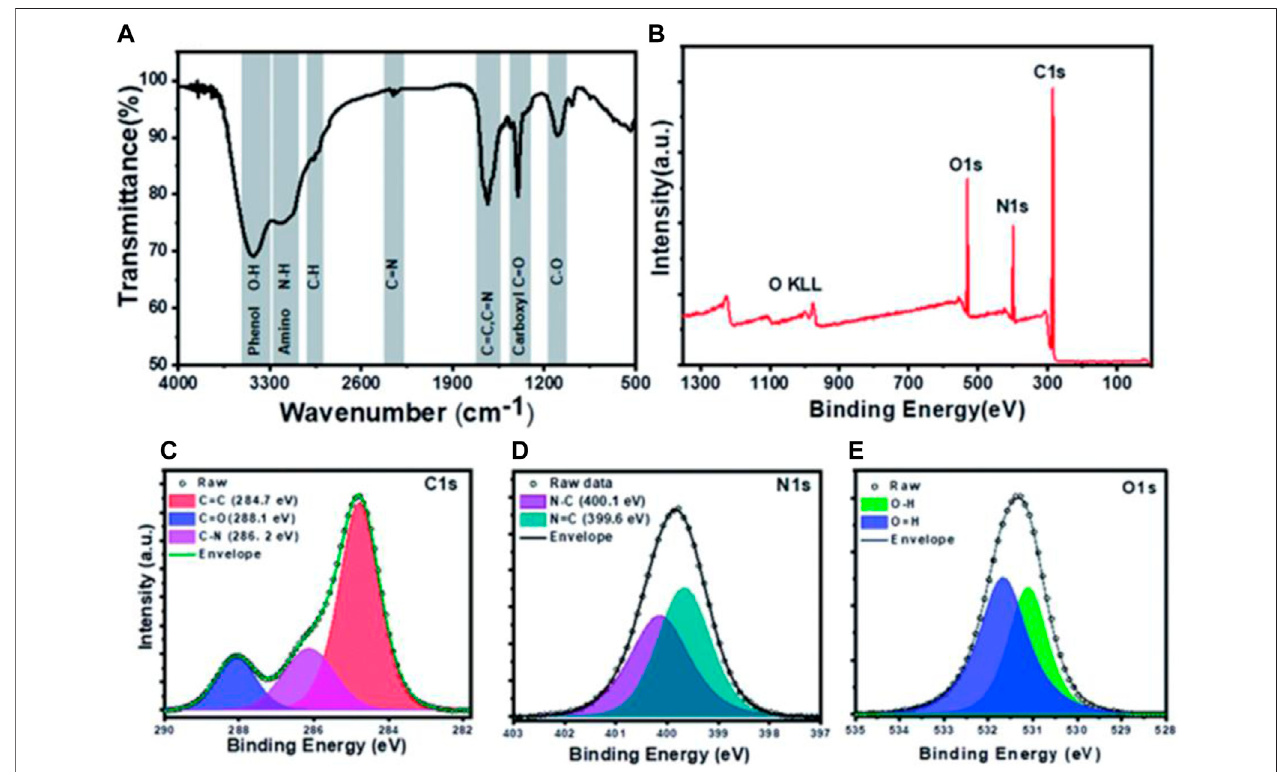
FIGURE 4 | Depiction for characterization of PNDs: (A) FTIR spectra (B) XPS spectrum showing peaks for oxygen, nitrogen, and carbon and (C) Deconvoluted high-resolution spectra for C1s, N1s, and O1s (Yadav et al.,